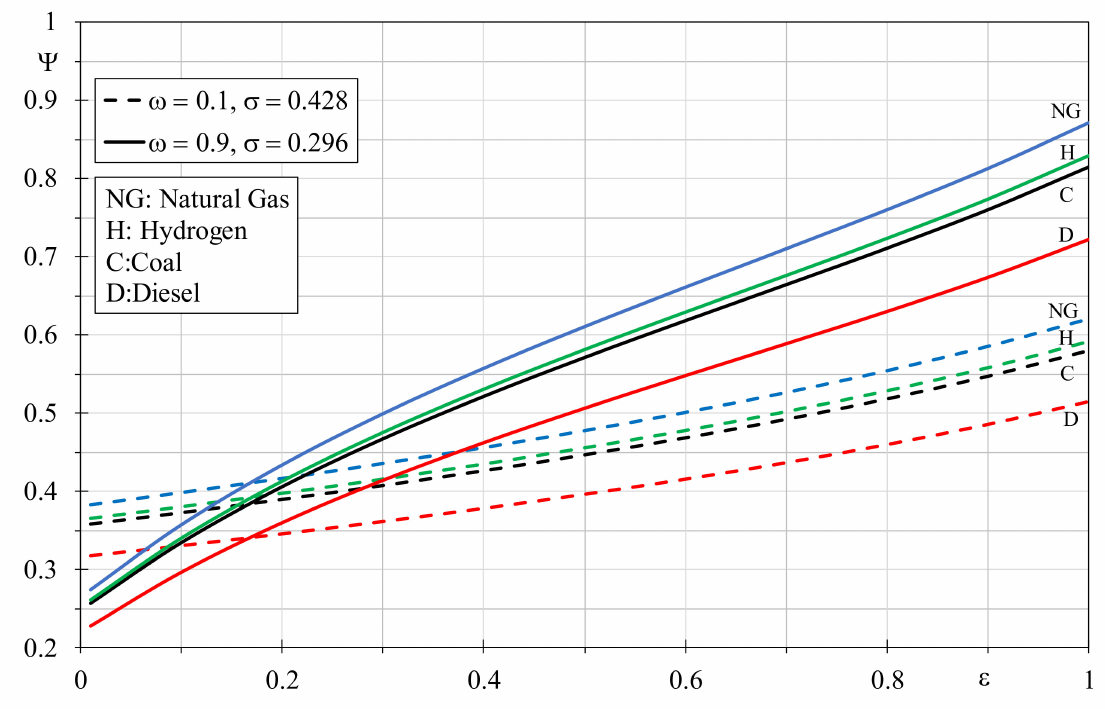
Figure 10. EQI related to the heat exchanger efficiency for the considered fuels for different couples of values concerning thermal capacity ratio and dimensionless temperature